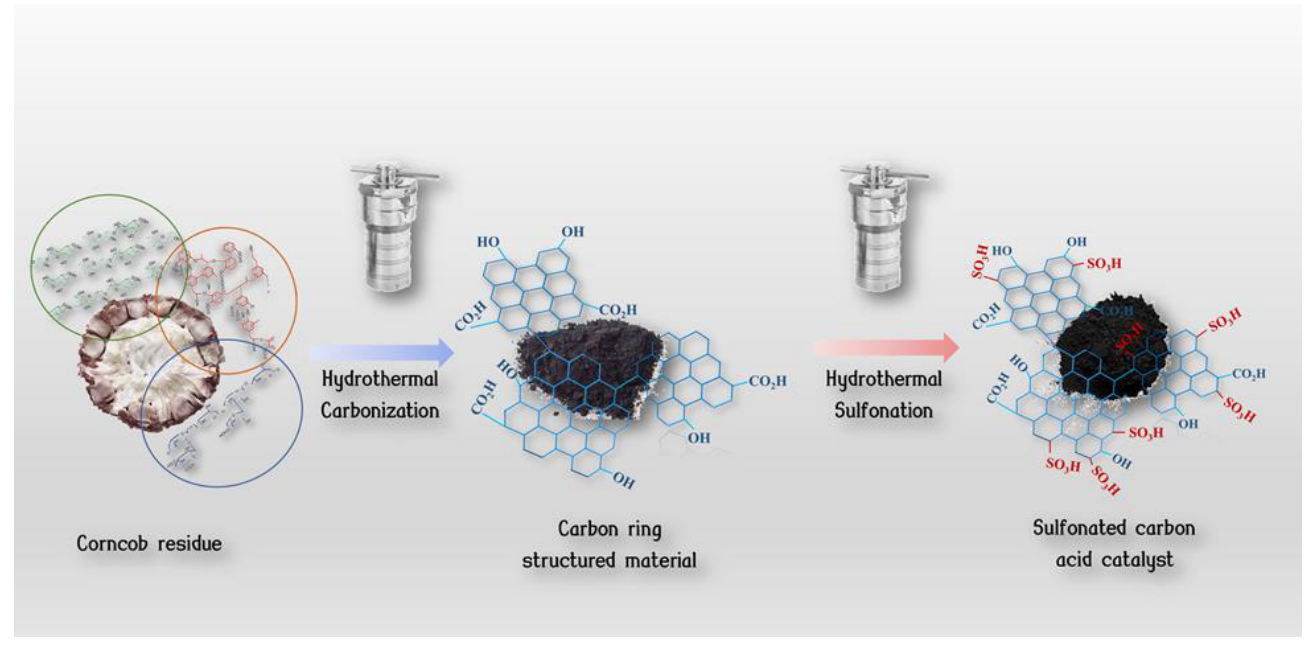
Fig. 3. Synthesis pathway of solid acid catalyst from corncob